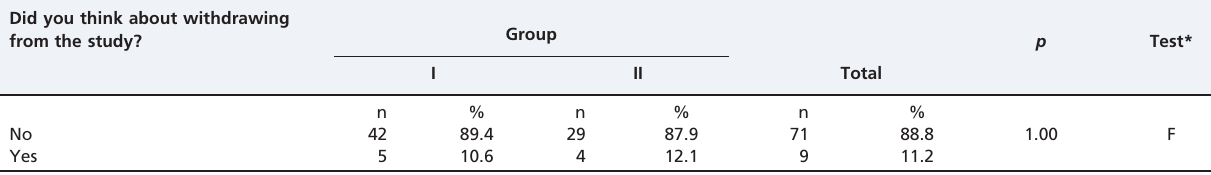
Table 3 - Participants who thought about withdrawing from the clinical